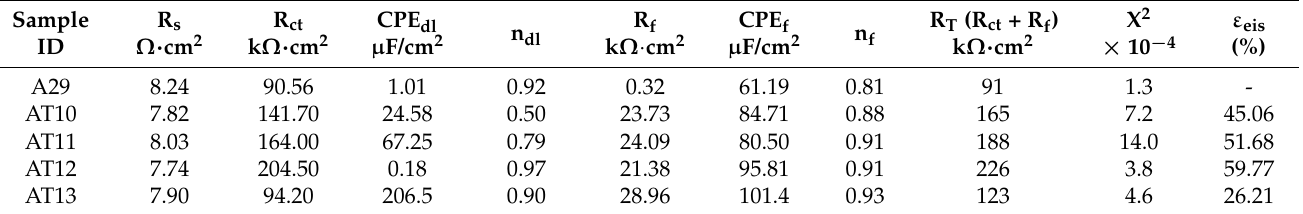
Table 8. EIS parameters obtained from the EC fitting for the samples solutionized at different